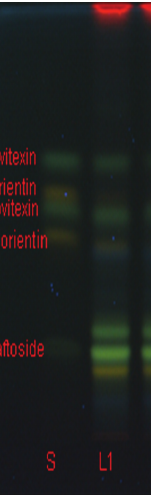
acid : acetic acid : water (100 : 11 : 11 : 27 v/v/v/v) gave